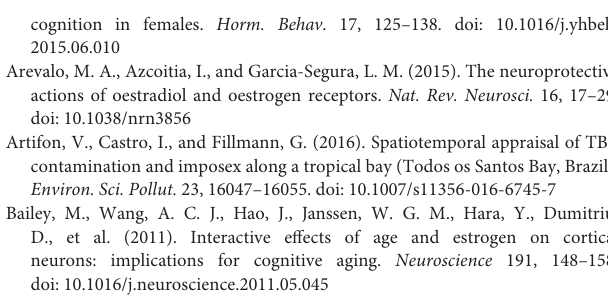
Supplementary Figure 2 | Correlation between memory recognition performance, ER α protein expression, and oxidative stress in female mice. The values of ER α protein expression in the PFC (A) and hippocampus (HCP) (B) were correlated with STM performance. The values of ER α protein expression in